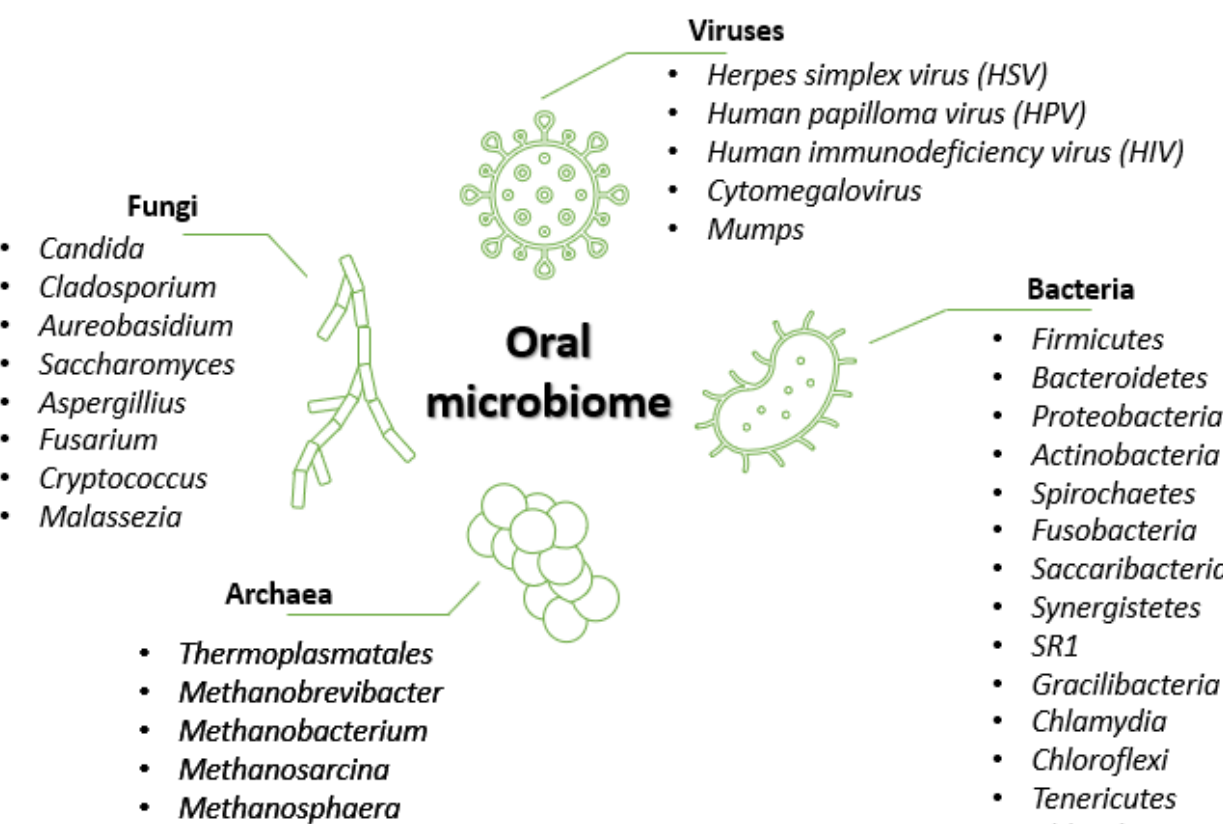
Figure 1. Oral microbiome composition. Created based on information from references in the literature [2,4,5,16,17].